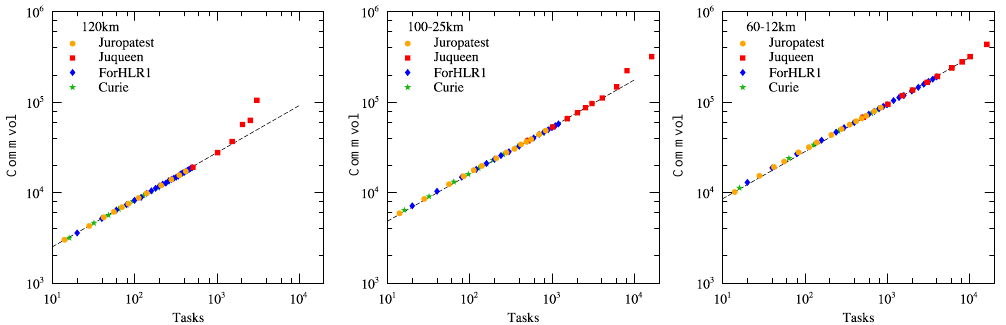
Figure 3. Communication volume as function of number of tasks for the three test cases (left: 120km; middle: 100–25km; right: 60–12km). The dashed lines correspond to an exponential relation with a power-law index of 0 . 52. For large numbers of tasks, a runaway growth can be seen for the 120km and to some extent also for the 100–25km